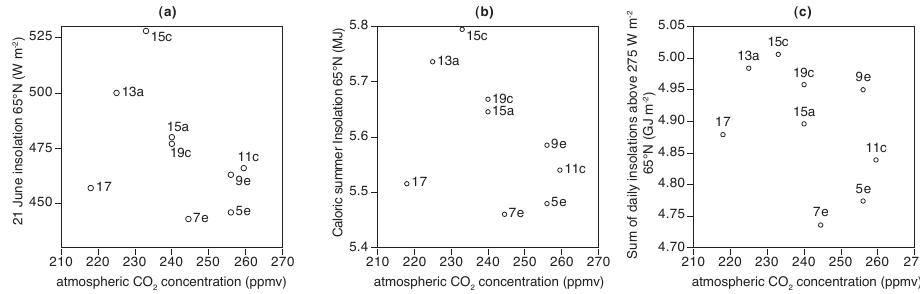
Fig. 7. Plot of atmospheric CO 2 and boreal summer insolation values at the time of glacial inception. (a) CO 2 concentration (L¨uthi et al., 2008) versus daily mean insolation at the summer solstice (21 June) at 65 ◦ N (Laskar et al., 2004); (b) CO 2 concentration (L¨uthi et al., 2008) versus insolation at 65 ◦ N integrated over the caloric summer (the 180 days of highest insolation, assuming a 360-day year) (Milankovitch, 1941; Berger, 1978) (c) CO 2 concentration (L¨uthi et al., 2008) versus insolation at 65 ◦ N integrated over all days for which insolation exceeds 275Wm − 2 (Huybers,